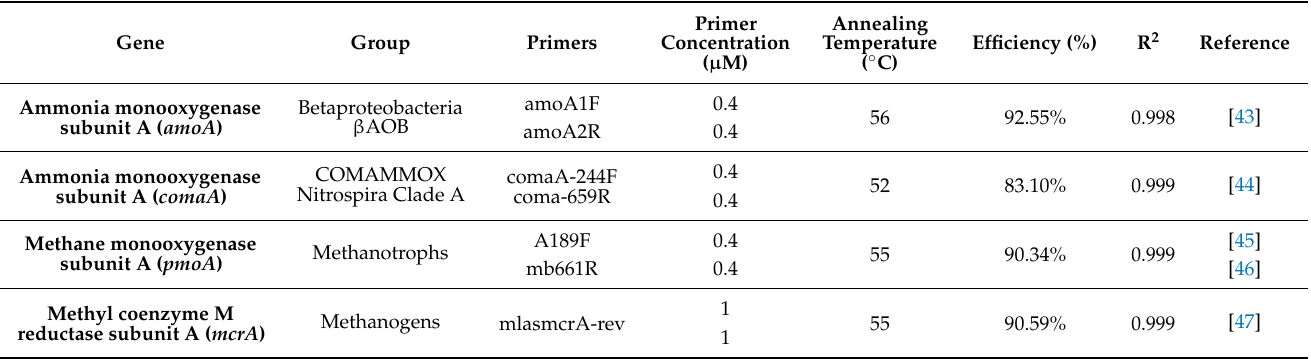
Table 1. qPCR table indicating its gene, group, primers, primers concentration, annealing temperature, efficiency, R 2 , and